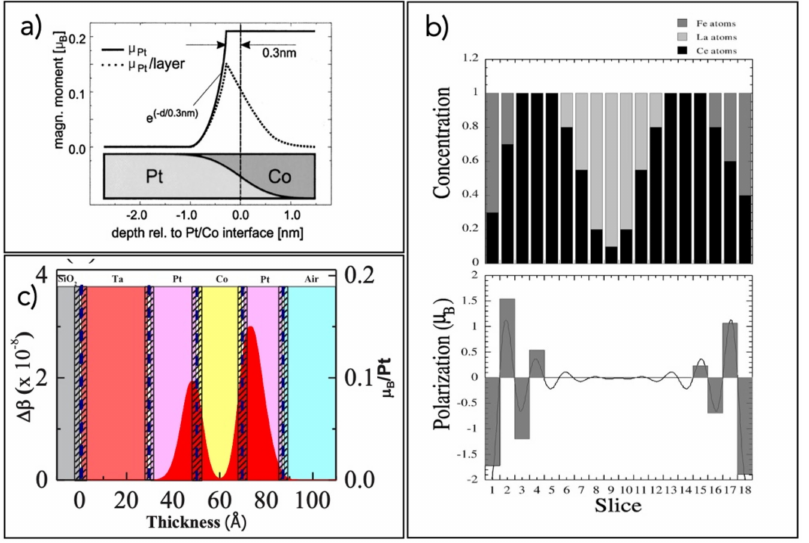
Figure 3. ( a ) Profile of the magnetic polarization induced per Pt atom (straight line) and per layer (dotted), together with the chemical profile of a Pt/Co interface (at the bottom) (reprinted figure with permission from [45]. Copyright (2001) by the American Physical Society); ( b ) profile of the Ce atomic concentration (upper part) and of the Ce 5d induced polarization (lower part) in a CeLaCe/Fe multilayer (reprinted figure with permission from [48]. Copyright (2002) by the American Physical Society); ( c ) magneto–optic depth profile of a Ta/Pt/Co/Pt heterostructure; red curves denote the in-depth distribution of the spin–polarized Pt atoms; the dashed lines indicate the corresponding interface positions; and the dashed rectangles between the layers indicate the corresponding interlayer roughness (reprinted figure with permission from [55]. Copyright (2020) by the American Physical